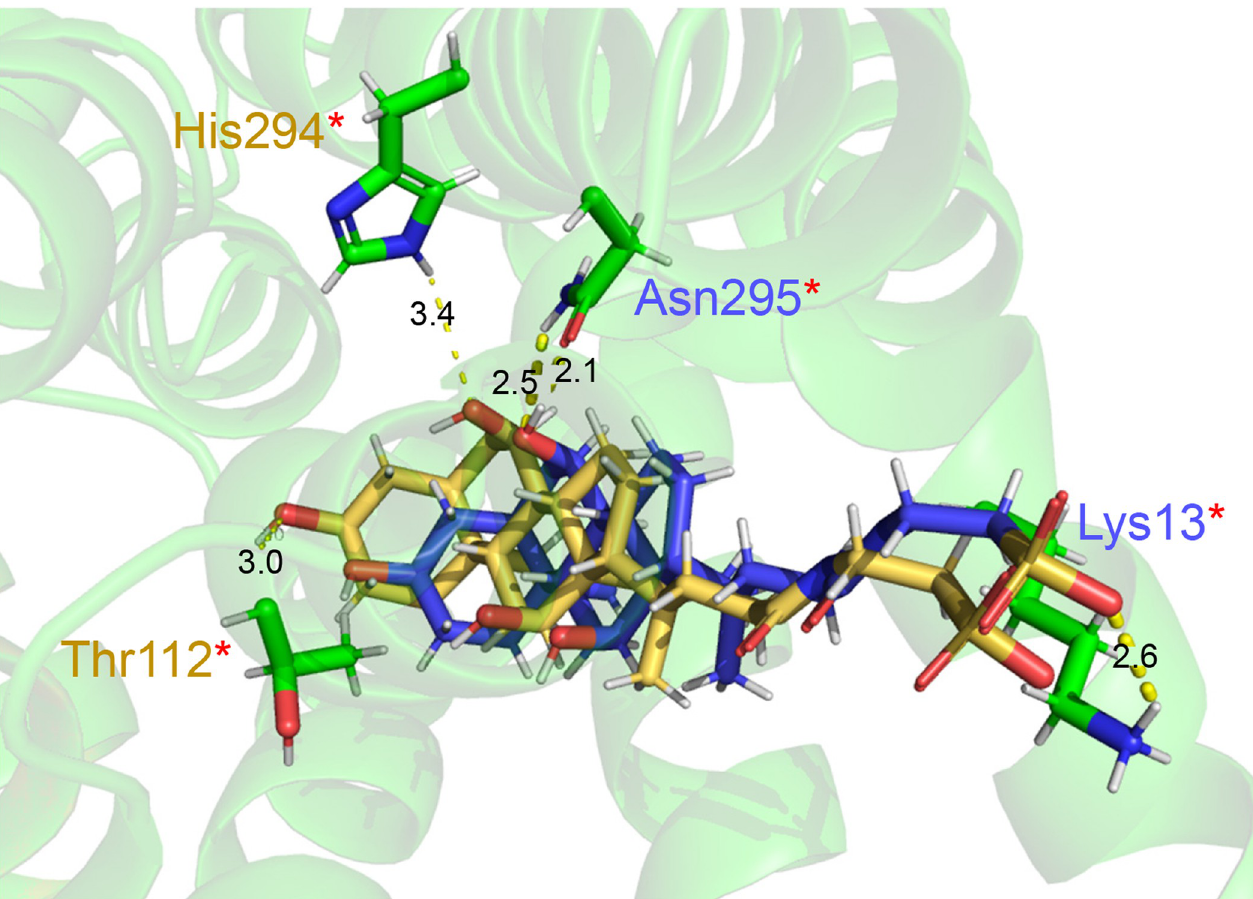
Fig 3. Taurocholate re-docking into the substrate-binding pocket of NmASBT. Superposition of taurocholate in the best-re-docking pose (yellow) and crystal structure (blue) (RMSD = 2.0 Å ). Hydrogen bonds between the residues of NmASBT binding pocket and taurocholate in both the crystal (blue; Lys 13 and Asn 295 ) and the best-re-docked (yellow; Thr 112 and His 294 ) complex structures are shown as yellow dotted lines, and NmASBT interacting residues (green) are depicted as sticks. The known hydrogen bonds are marked in red asterisks.